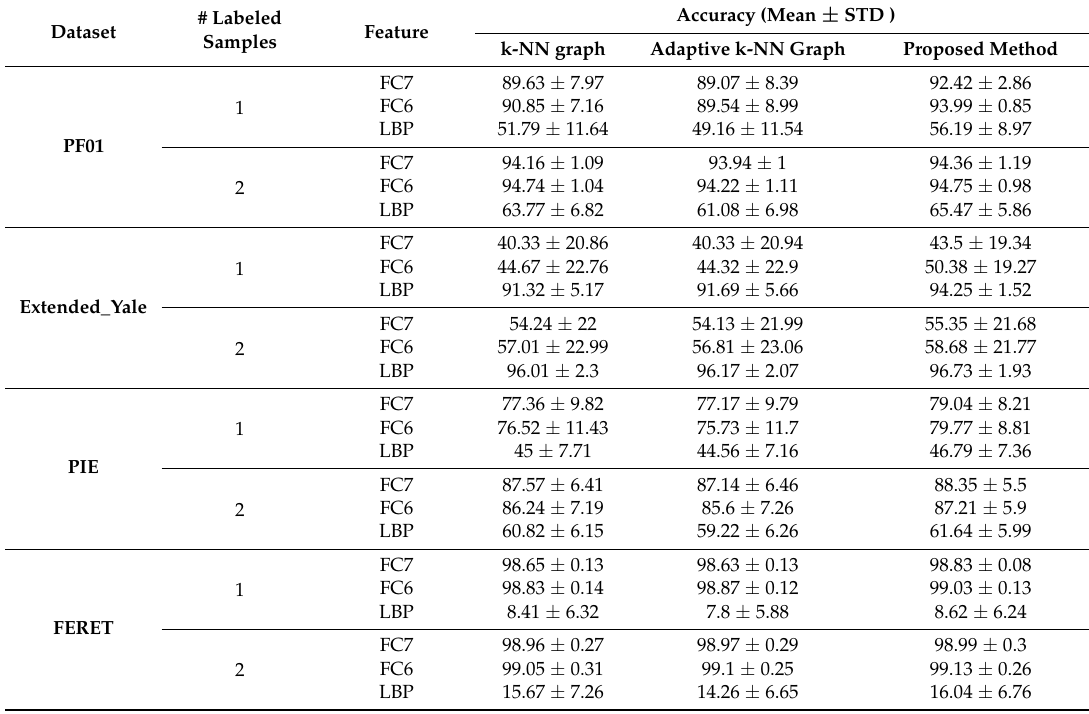
Table 3. Mean accuracy and standard deviation of label propagation (LP) for the individual feature and the proposed method. K-NN = k-Nearest